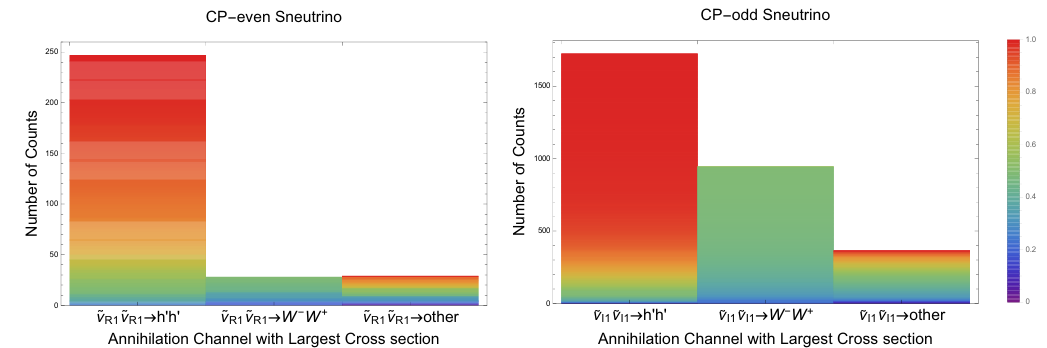
Figure 4 . Histogram counting the number of spectrum points with the largest annihilation cross section being in either the h 0 h 0 , W + W (cid:0) or other channel. This has been done for spectrum points which have a CP-odd (left) or CP-even (right) sneutrino LSP. Each count is also coloured by the normalised cross section (so that the sum of annihilation cross section channels for a given point is unity), where a red coloured point means the given annihilation channel has a larger cross